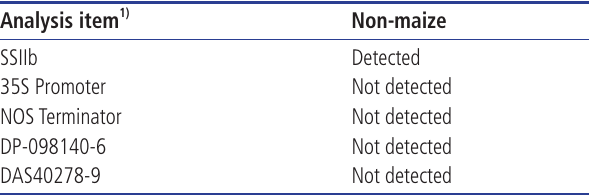
Table 1. Qualitative analysis of genetically modified maize Analysis item 1)